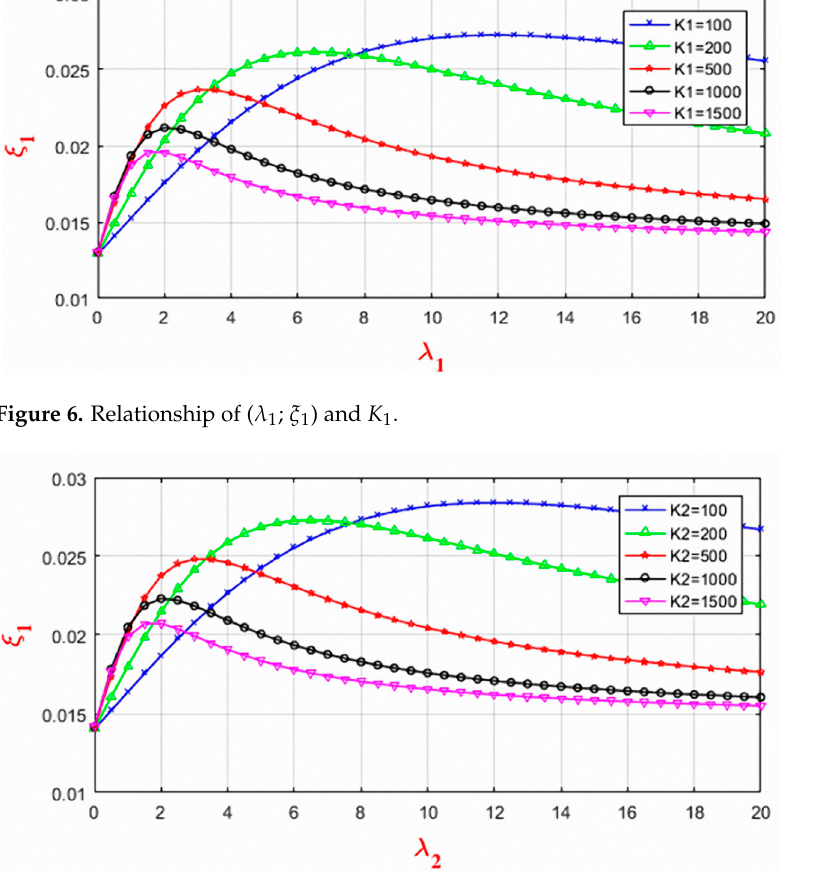
Figure 7. Relationship between λ 2 and ξ 2 for different values of K 2 . Table 4. Damping ratio ξ 1max with λ 1.